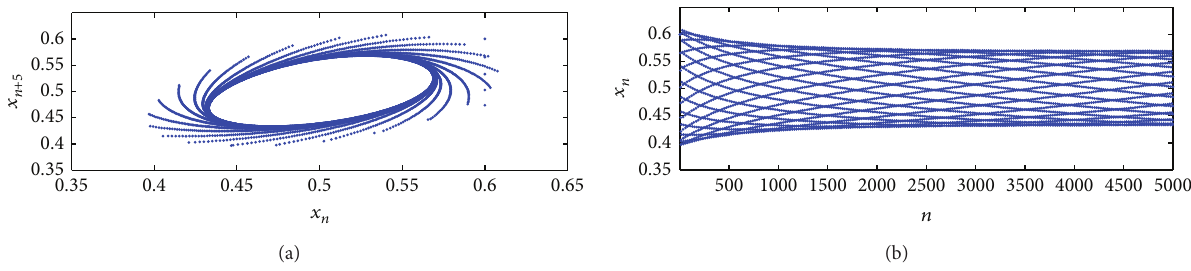
Figure 4: A stable invariant closed circle bifurcating from 𝑥 ∗ , where 𝑎 1 = 1.6 , 𝑎 2 = 0.8 , 𝑚 = 5 , and 𝑟 = 0.238 > 𝑟 1 = 0.2372 .